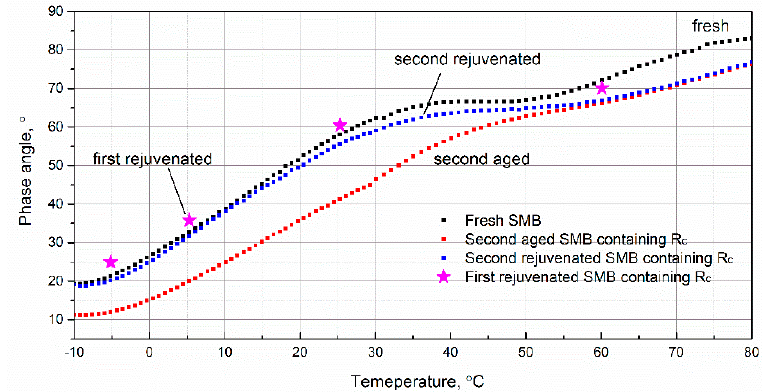
Figure 9. Effect of rejuvenating system on the phase angle of second-aged SMB.